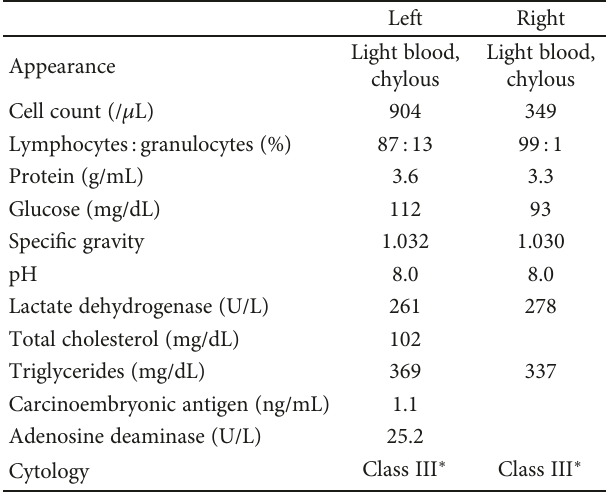
Figure 1: Computed tomography of the chest and abdomen depicted bilateral pleural e ff usion (arrows) (a, b) and ascites (arrowheads) (c). Axillary lymph adenopathy (circles) (b) and inguinal lymph adenopathy (circles) (d) were present. Table 2: Pleural e ff usion